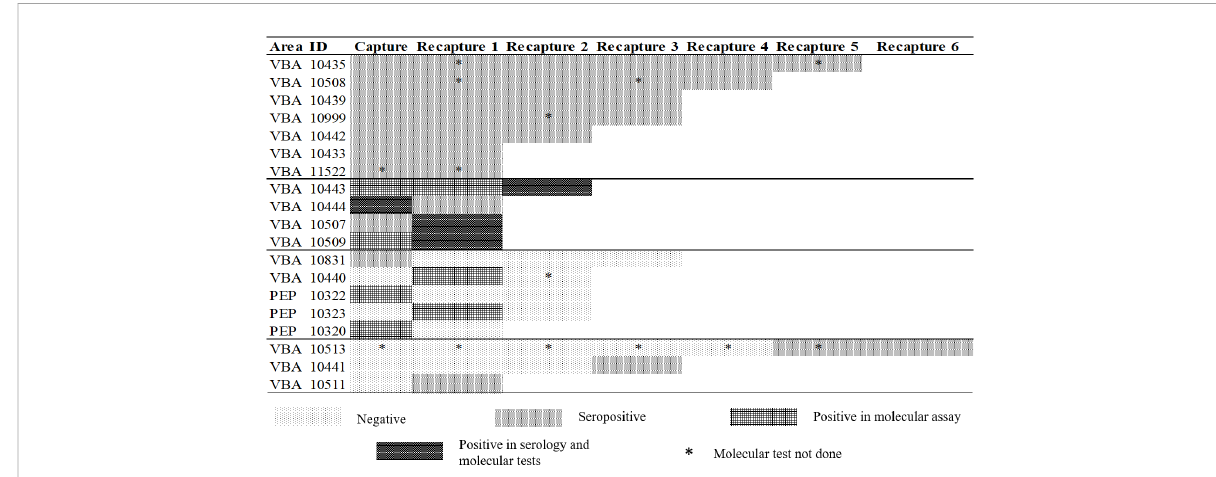
FIGURE 6 Longitudinal results of 19 South American coatis ( Nasua nasua ) infected by Leishmania infantum in urban forest fragments in Campo Grande, Mato Grosso do Sul, Midwest Brazil, from March 2018 to April 2019. ID: Identi fi cation number; PEP: conservation unit Parque Estadual do Prosa ; VBA: residential rea Vila da Base Ae ́ rea . Positivity in molecular was obtained either by HSP70 sequencing or MC1/MC2 PCR. Seropositivity was considered when both ELISA and DPP ® CVL tests were